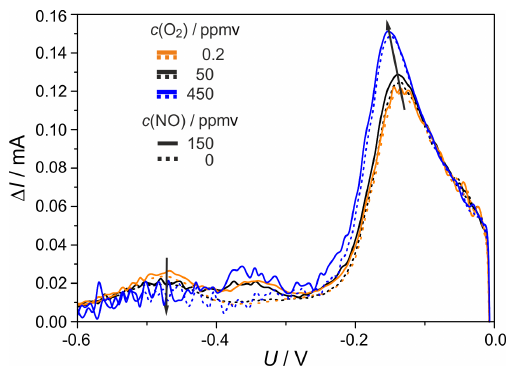
Figure 12. SWV at different O 2 concentrations and T = 750 ◦ C; other experimental conditions as declared in Fig.